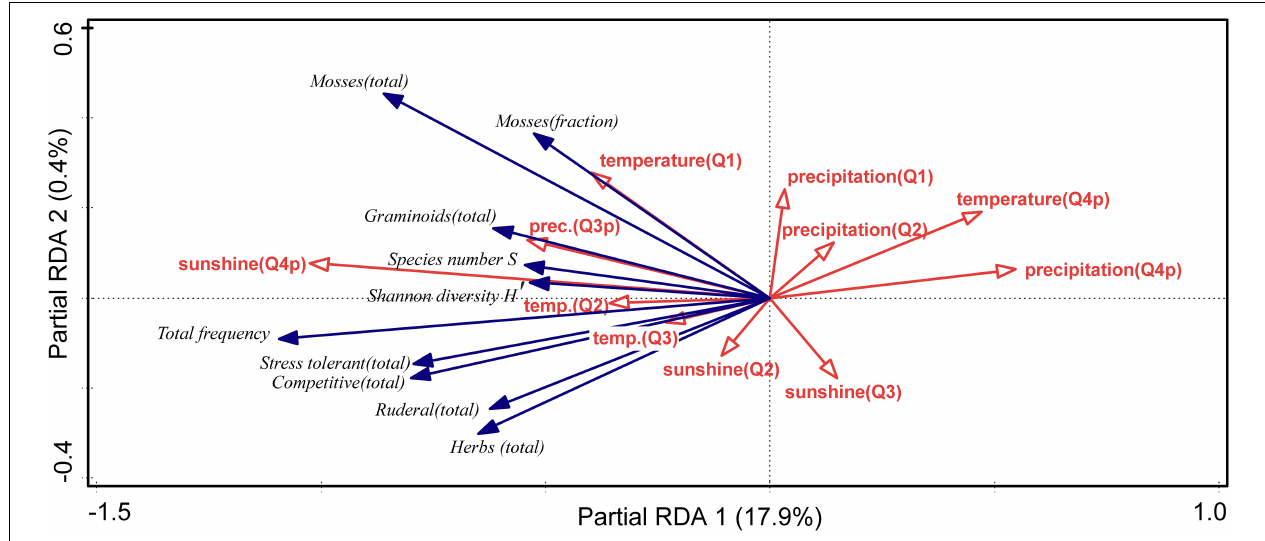
FIGURE 5 | pRDA showing the environmental effects on diversity (S, H (cid:48) ), total frequency, functional groups, and strategy types of the grazed sites (total frequencies and fractions indicated for the latter). Explanatory weather variables (sunshine duration, temperature, precipitation) shown with quartals in brackets (Q1 Jan–Mar, Q2 Apr–Jun, Q3 Jul–Sep, Q3p Jul–Sep previous year, Q4p Oct–Dec previous year). Partial RDA (site as covariate) on all community parameters (variables with fit > 5% shown), explained variation of axes indicated, p =